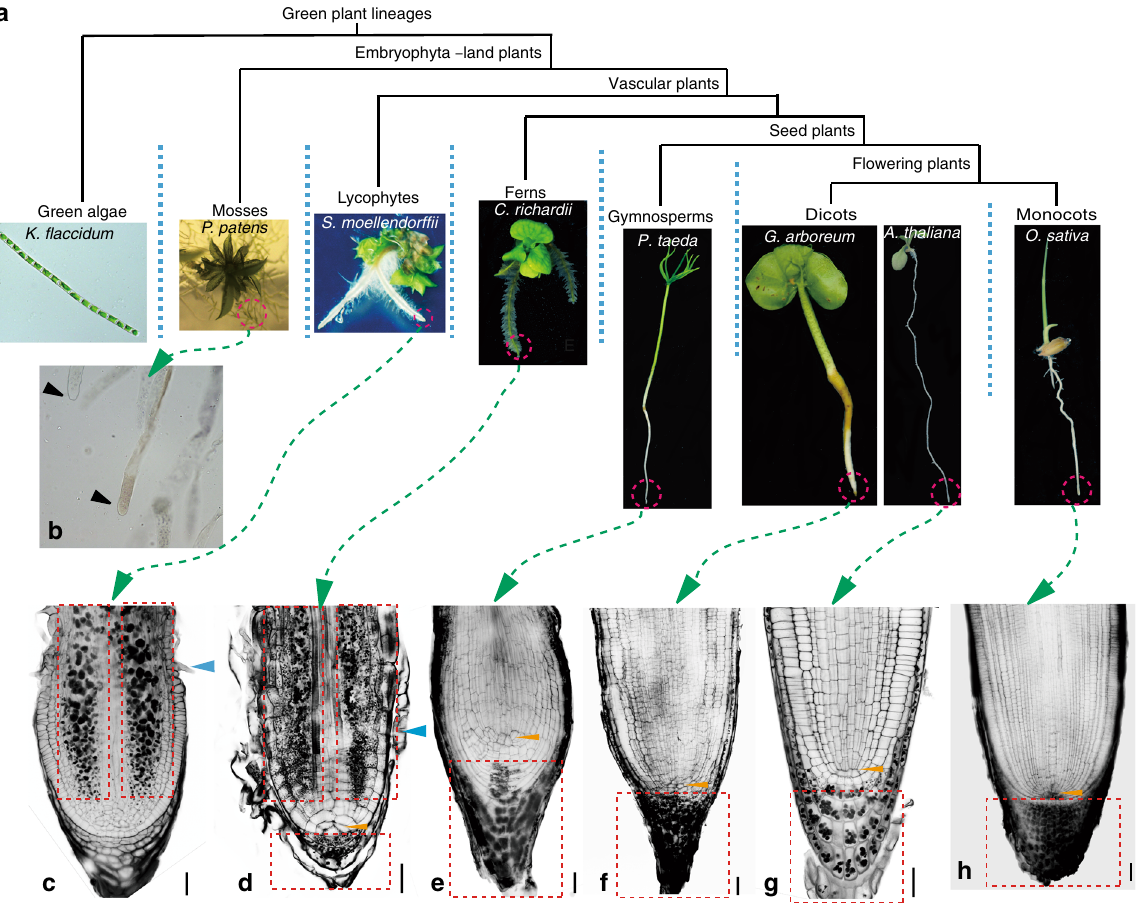
Fig. 2 Exclusive root apex-speci fi c amyloplast localization in seed plants. a Living representative species from different plant lineages included in the analysis (from left to right): K . fl accidum (green alga), P . patens (moss), S . moellendorf fi i (lycophyte), C . richardii (fern), P . taeda (gymnosperm), G . arboreum , and A . thaliana (dicots), and O . sativa (monocot). b Lugol ’ s staining of the rhizoid ( P . patens ). c – h mPS-PI staining of the root tips from S . moellendorf fi i ( c ), C . richardii ( d ), P . taeda ( e ), G . arboreum ( f ), A . thaliana ( g ), and O . sativa ( h ). The blue arrows indicate root hair initiation. The yellow arrows indicate the apical cell (QC-like cell) in the fern C . richardii and the QC in seed plants. The dashed red rectangles indicate the zone with amyloplasts. Scale bars, 20 µ Fig. 10d, e). The shootward auxin transport ef fi ciency in the root gravitropism (Fig. 3f). Representative canonical PINs from root of fern C . richardii is much lower than that in the P . taeda the non-vascular plant, the moss P . patens (i.e., PpPINA and and largely NPA-insensitive (Supplementary Fig. 10e). These PpPINB from clade 6), the basal vascular plants, the lycophyte S . results suggest that the ef fi cient shootward auxin transport along moellendorf fi i (i.e., SmPINR and SmPINU from clade 6), and the with the required functional PIN proteins for fast root fern C . richardii (i.e., CrPINJ and CrPINN from clade 7), all failed gravitropism have originated in the seed plants after the divergence from the basal vascular plant lineages. Notably, in fl owering plants, such as Arabidopsis and O . sativa , there is only one PIN2 gene, whereas there are two PIN genes in gymnosperm P . taeda and P . abies with the functional equivalent to the Arabidopsis PIN2 , suggesting that a duplication event of the PING/H progenitor occurred during the evolution of gymnosperms. Heterologous expression of the PIN2 gene from the fl owering plant G . arboretum ( GaPIN2 ) in Arabidopsis successfully complemented the Arabidopsis pin2 mutant phenotype, indicat- ing that this protein is functionally equivalent to Arabidopsis AtPIN2 (Fig. 3k – m). A recent report showed that the monocot rice PIN2 gene ( OsPIN2 ) also could rescue the Arabidopsis pin2 mutant phenotype 45 . These successful interspecies complementa- tion experiments imply that the unique PING/H and PIN2 with fast gravitropic function appeared and evolved in gymnosperm and fl owering plant lineages since the separation of the seed plants from the vascular plants.